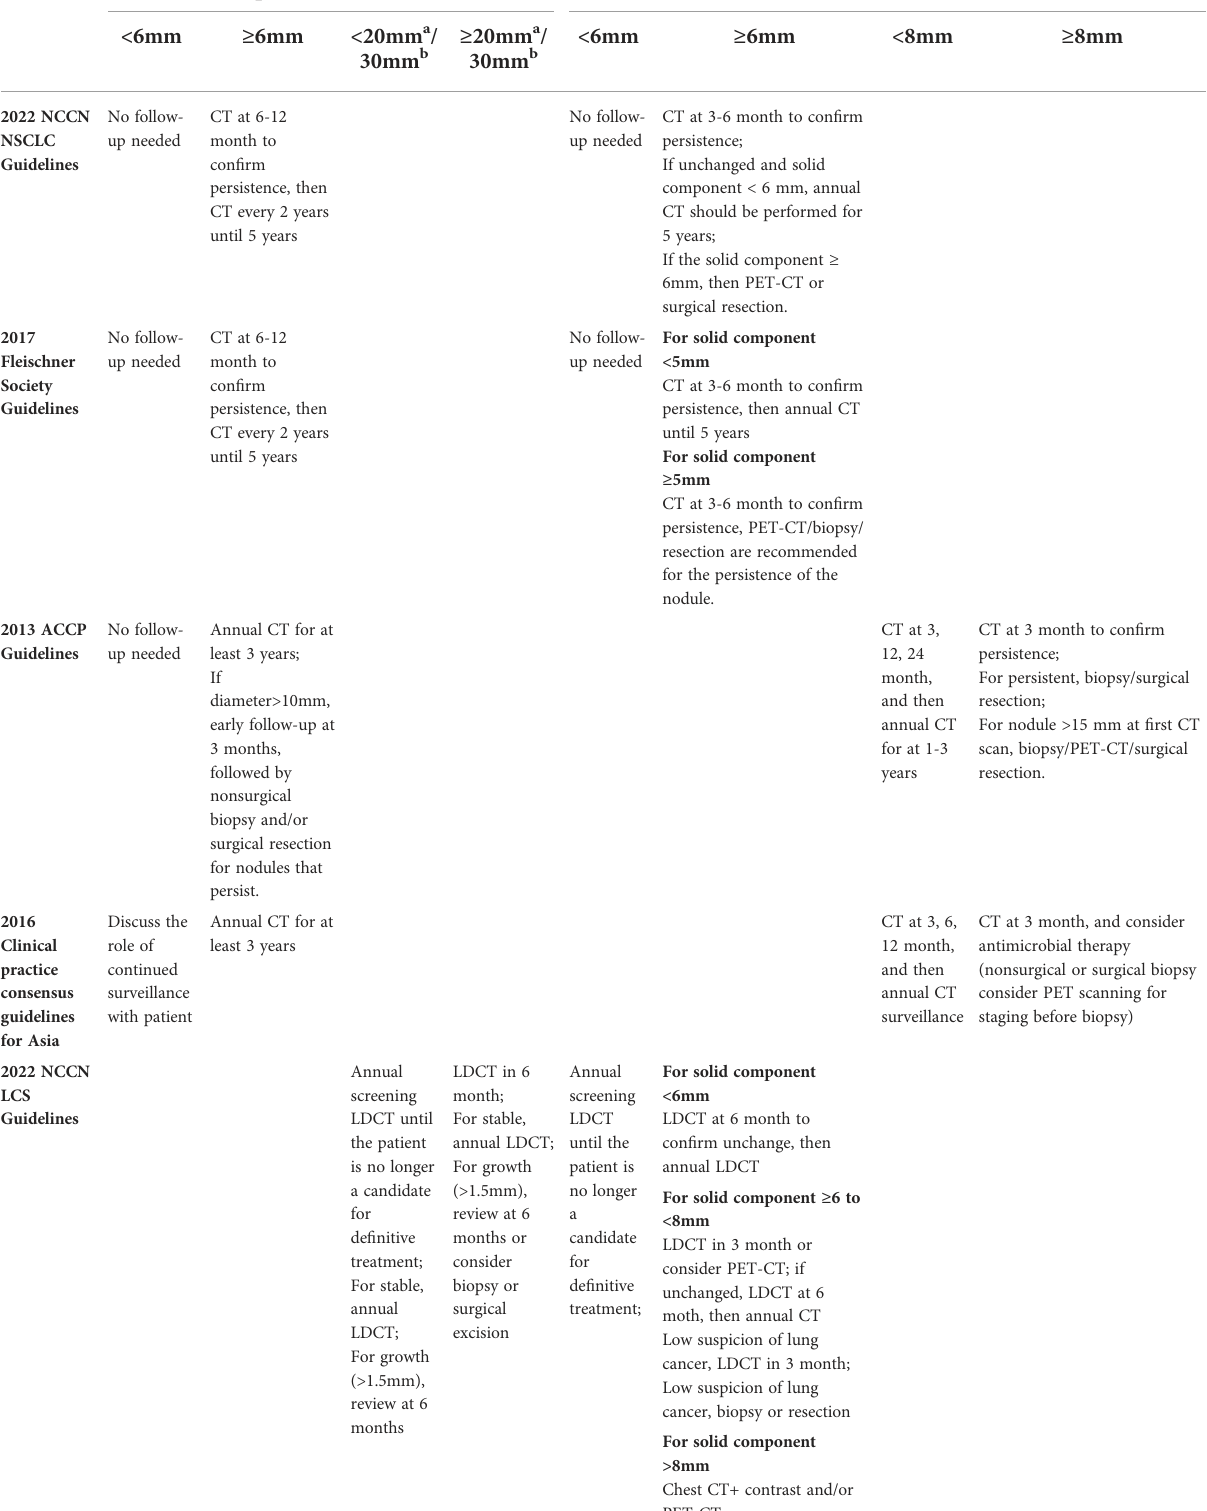
TABLE 3 Differences in follow-up strategies of SSN in